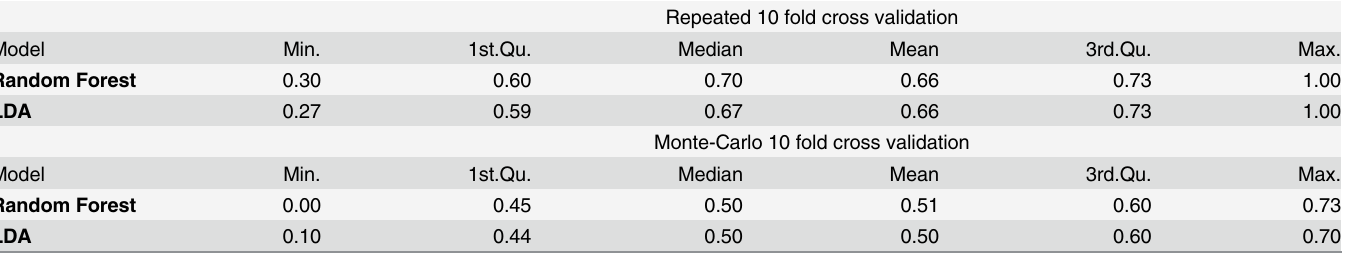
Table 5. Accuracy results of repeated 10 fold cross validation of the Random Forest and Linear Discriminant Analysis (LDA) models built to clas- sify urine samples from patients with prostate cancer and cancer-free controls based on the presence or absence of